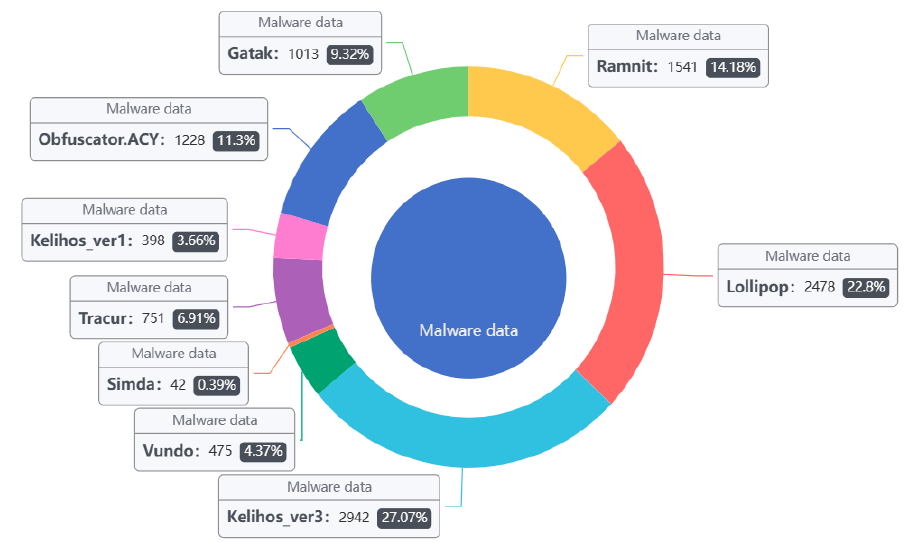
Figure 5. Kaggle dataset sample distribution.